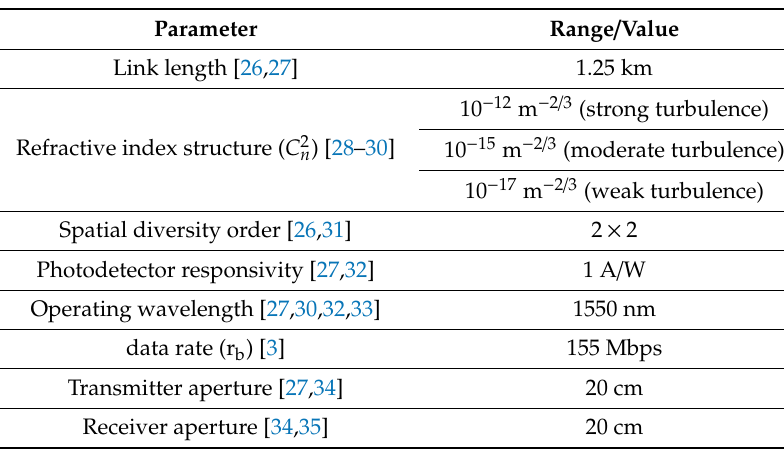
Table 1. Link design